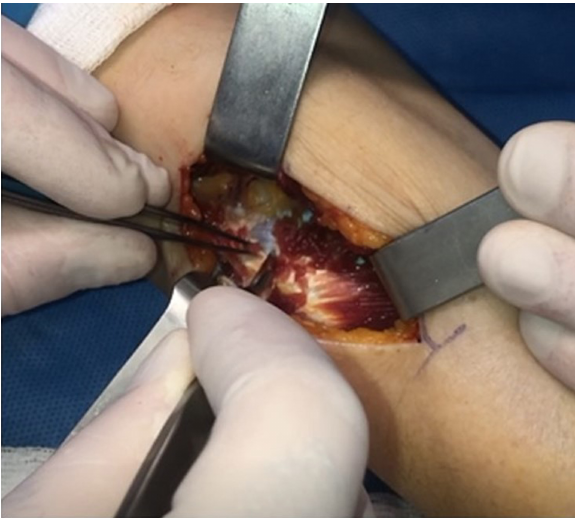
Figure 2. The supinator muscle is exposed. Proximally, the fascia and muscle are started to be loosened from the